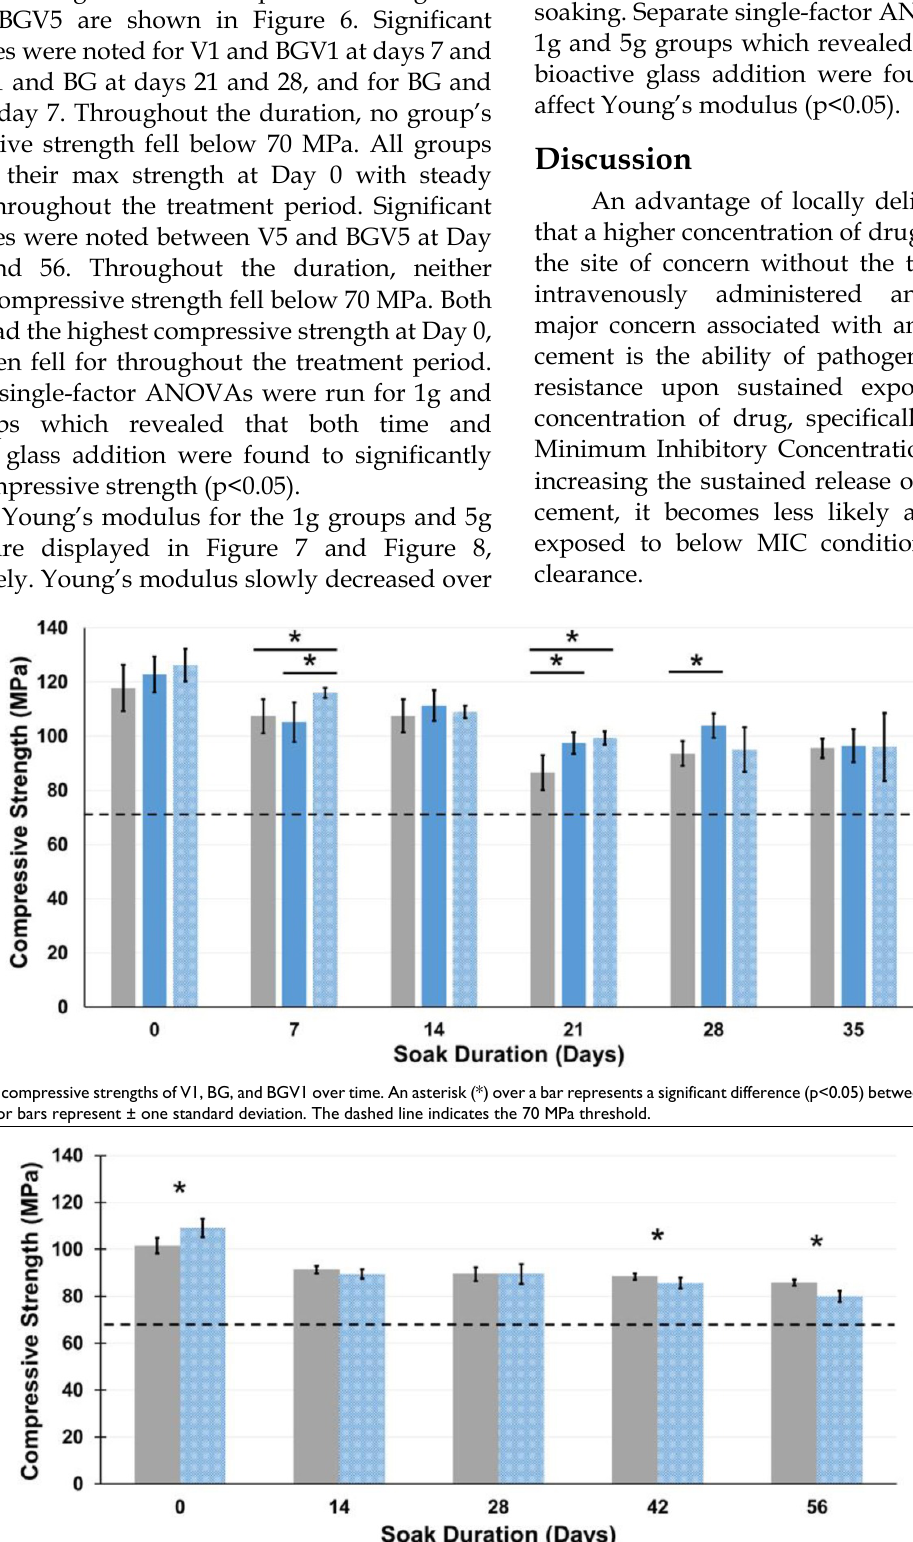
Figure 6. The compressive strengths of V5 and BGV5 over time. An asterisk (*) above a time point represents a significant difference (p<0.05) between the groups (n=5) at that time duration. Error bars represent ± one standard deviation. The dashed line indicates the 70 MPa